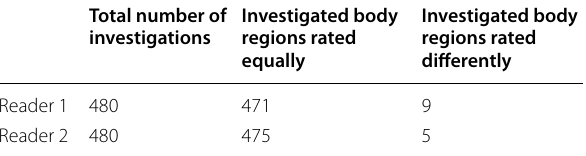
Each patient’s investigation is divided into 5 different body regions leading to 480 body regions to investigate per acquisition time